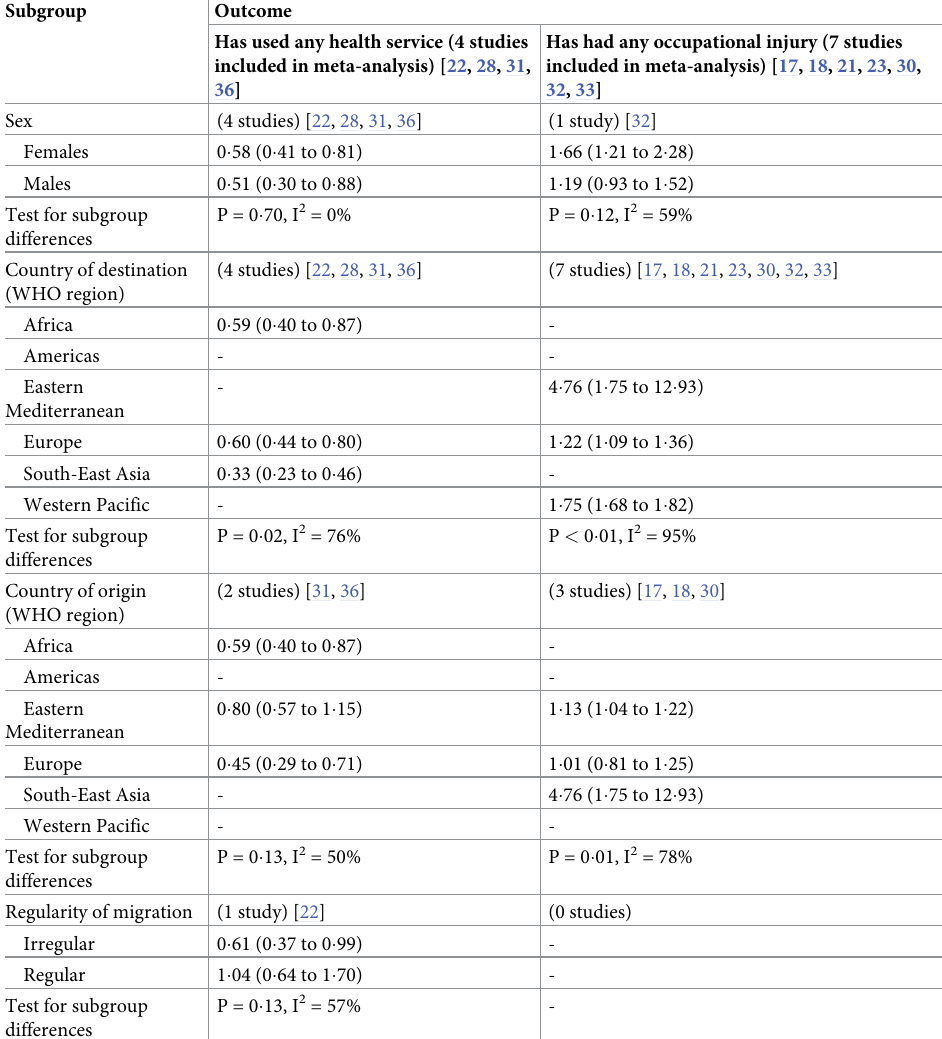
Table 2. Subgroup analyses for outcomes with meta-analysis.